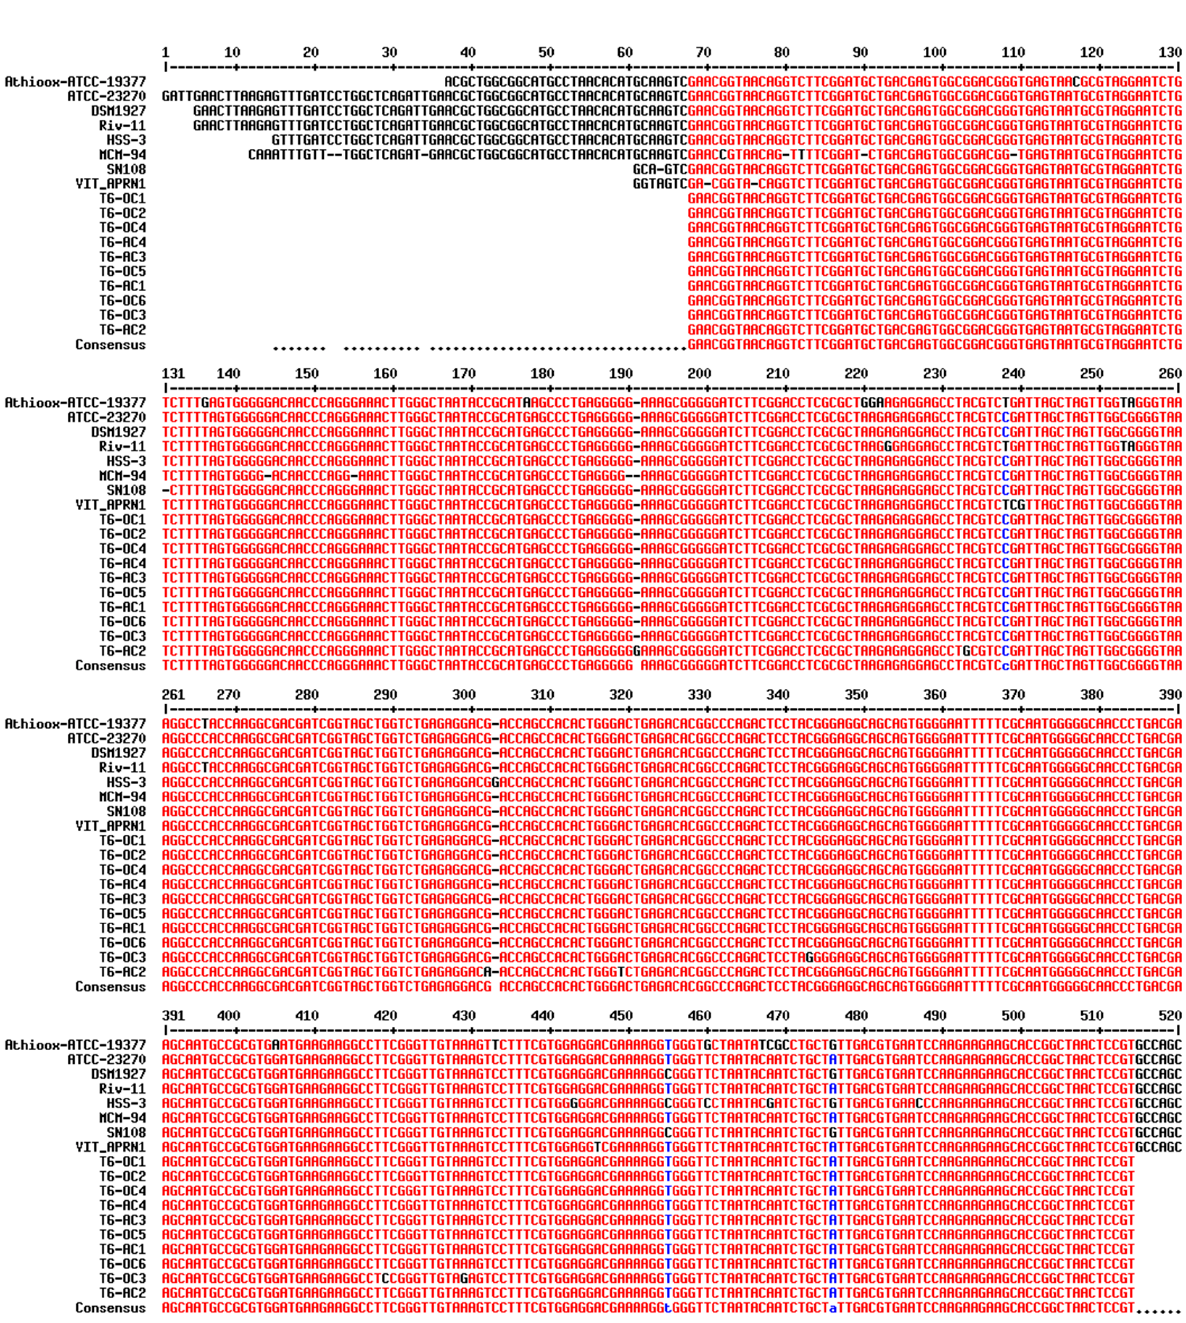
Figure 2. Alignment of the sequences obtained versus the sequences of representative strains for Subclades 2A and 2B from Nuñez et al. [41]. Red: consensus level of 95%; blue: consensus level of 50%. Created with MultAlin online software [42].